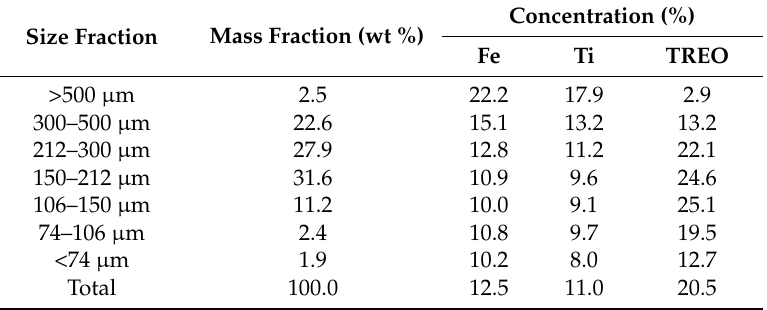
Table 2. Mass fraction (wt %) and concentration of main elements (%) of feed sample as a function of size fractions. TREO, Total rare earth